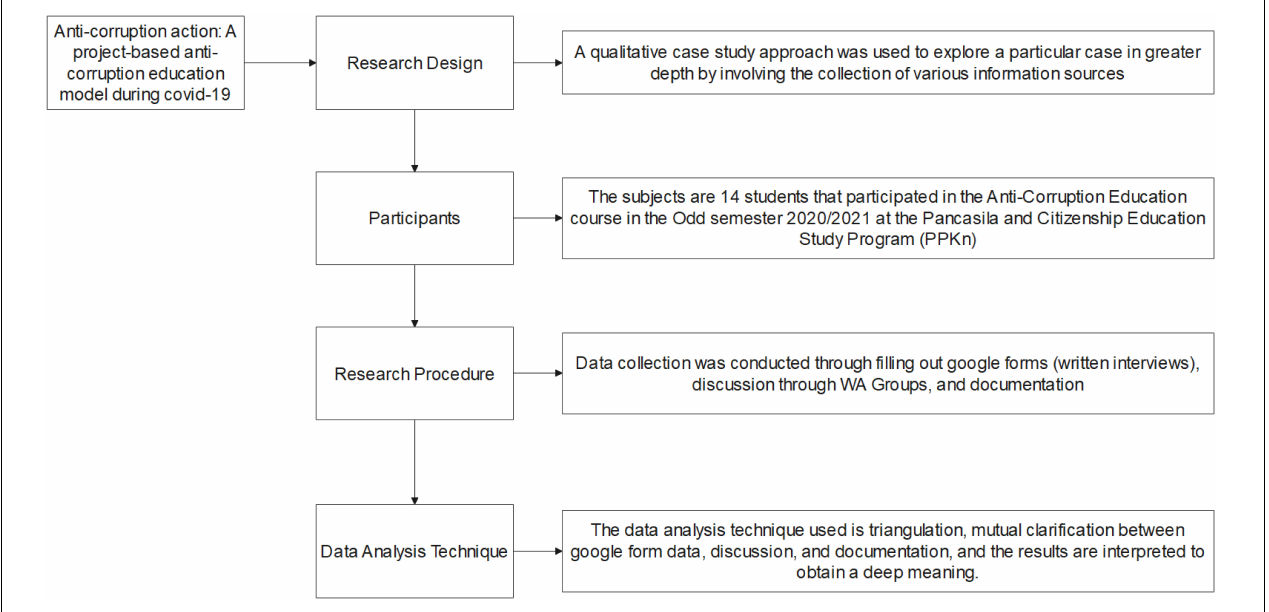
FIGURE 1 | Flow research anti-corruption action: A project-based anti-corruption education model during COVID-19.